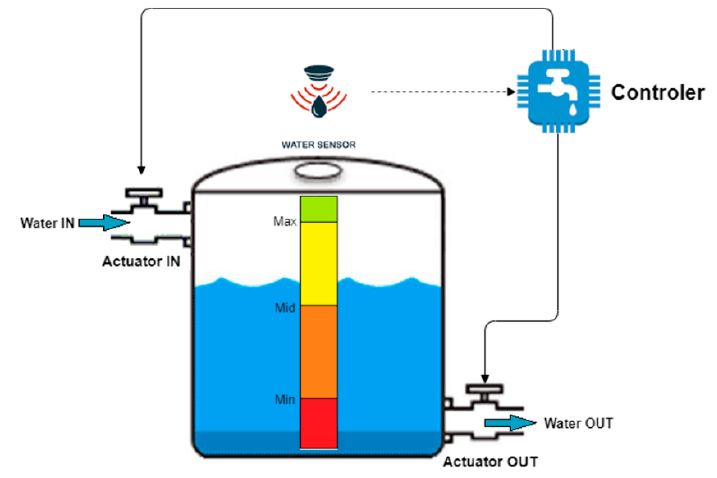
Figure 2. A prototype water tank with sensors to monitor and control the water level.